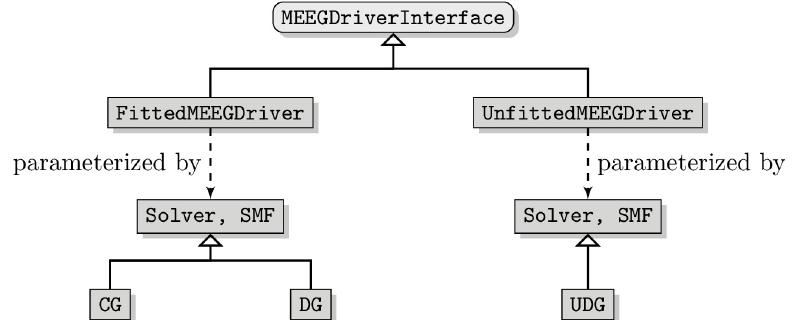
Fig 1. DUNEuro driver interface diagram. Diagram showing the structure of the driver interface and its implementations. The SourceModelFactory is abbreviated as SMF .